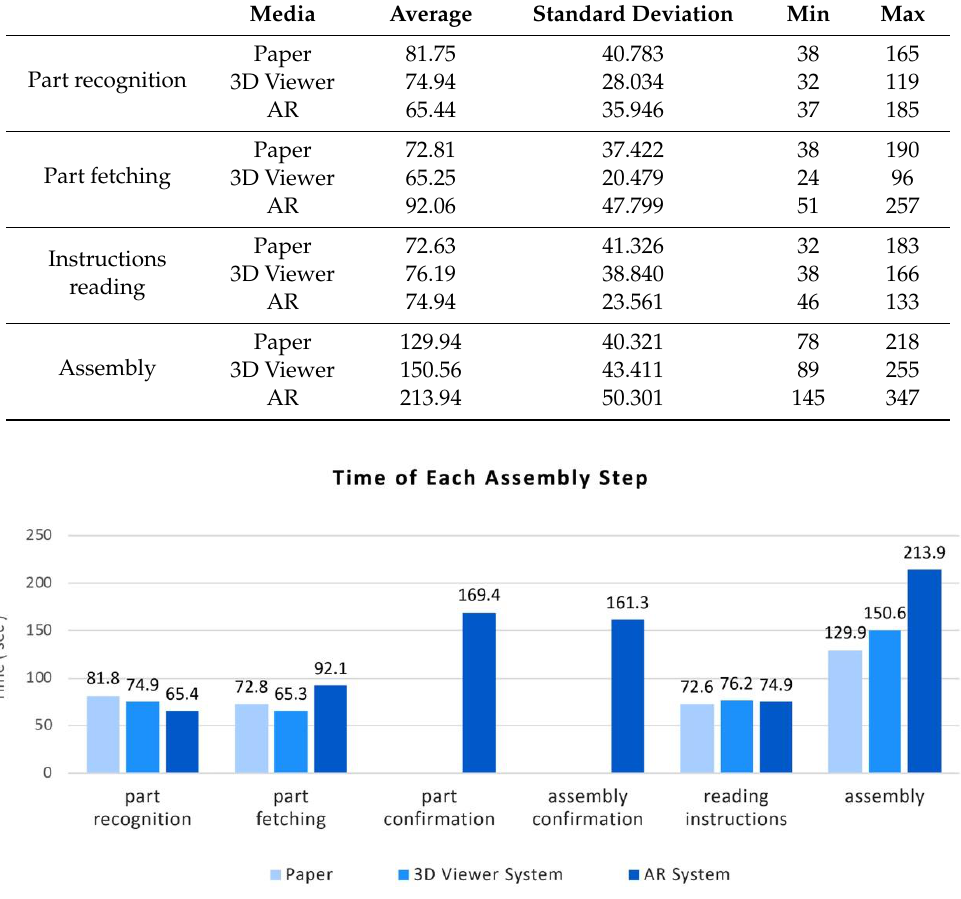
Table 5. Experimental result of assembly errors (units: # of times).